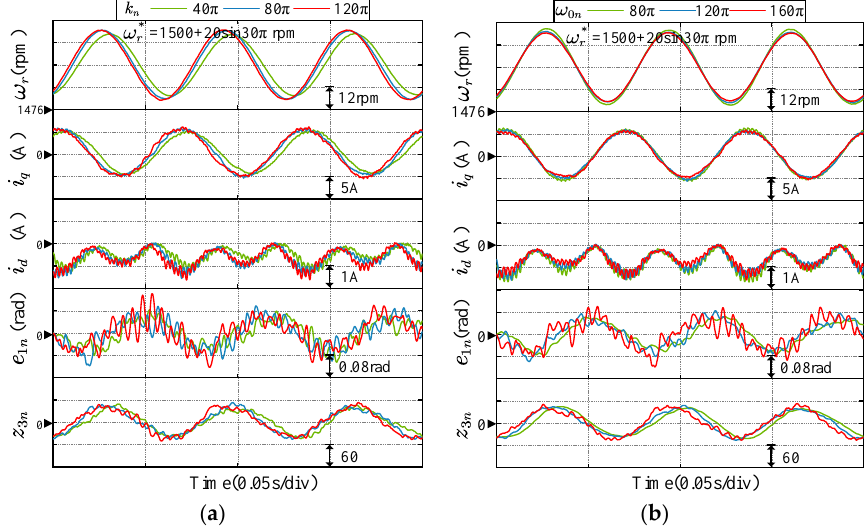
Figure 14. Experimental results of the speed response with sinusoidal speed reference. ( a ) Under different k n , where ω 0 n = 160 π , k n = [ 40 π ,80 π ,120 π ] ; ( b ) under different ω 0 n , where k n = 80 π , ω 0 n = [ 80 π ,120 π ,160 π ]